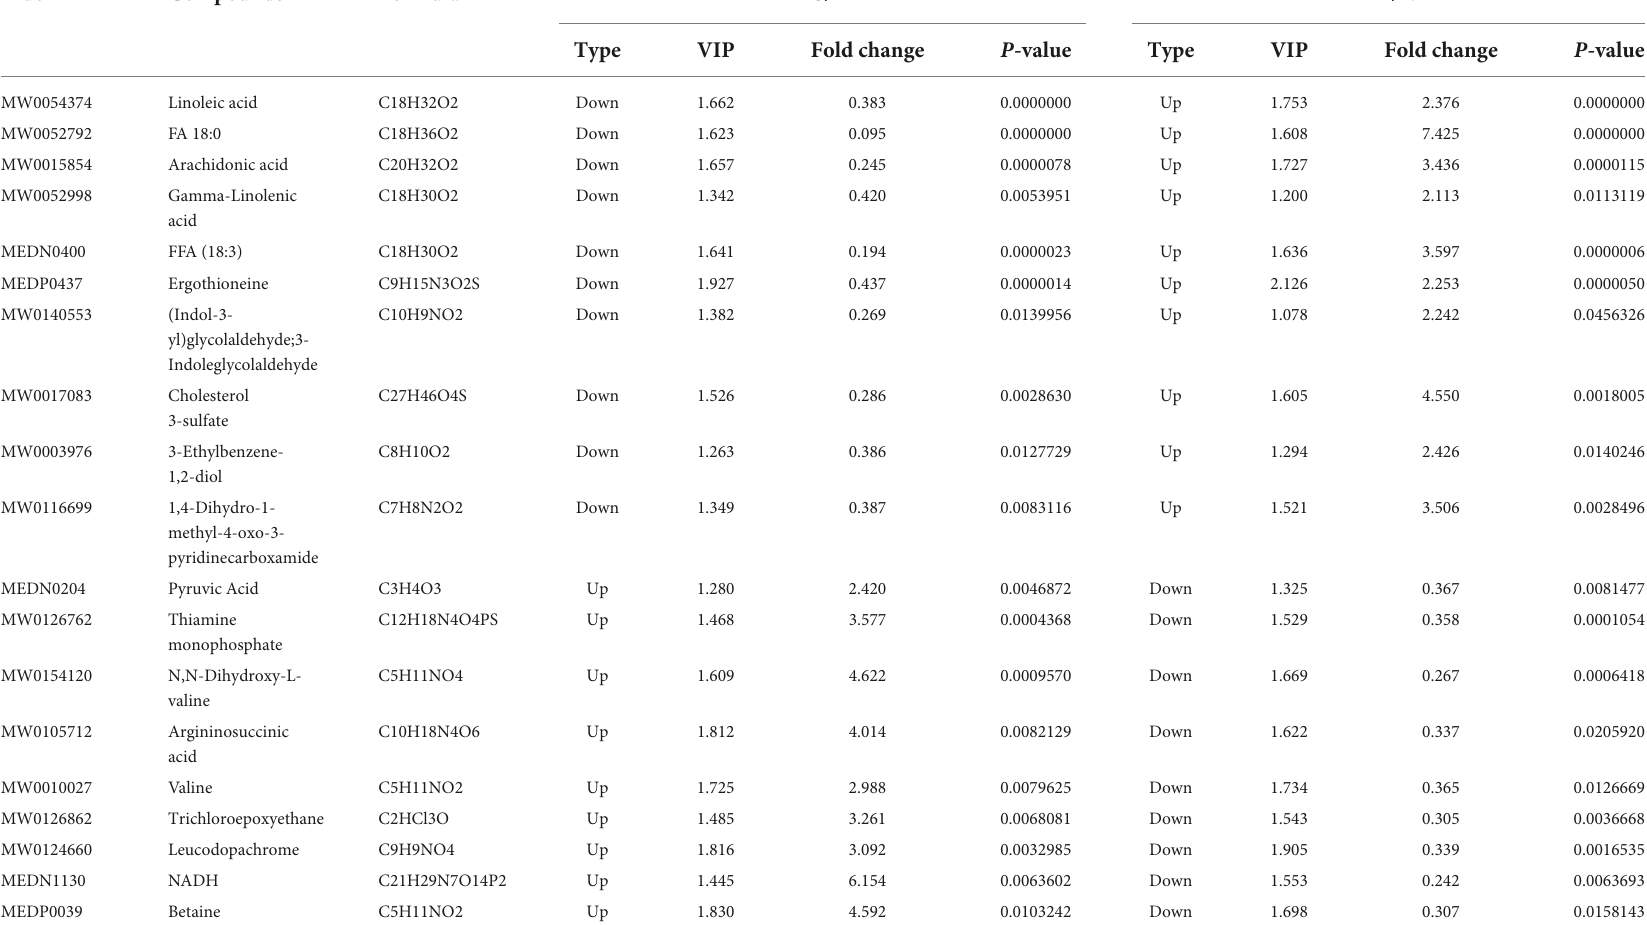
TABLE 2 Nineteen differential metabolites common to three groups (ND, HFD,